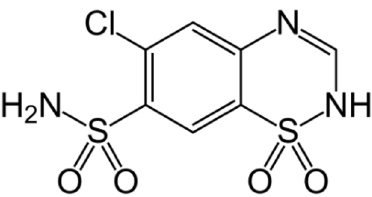
Figure 1. Chemical structure of chlorothiazide (CT).